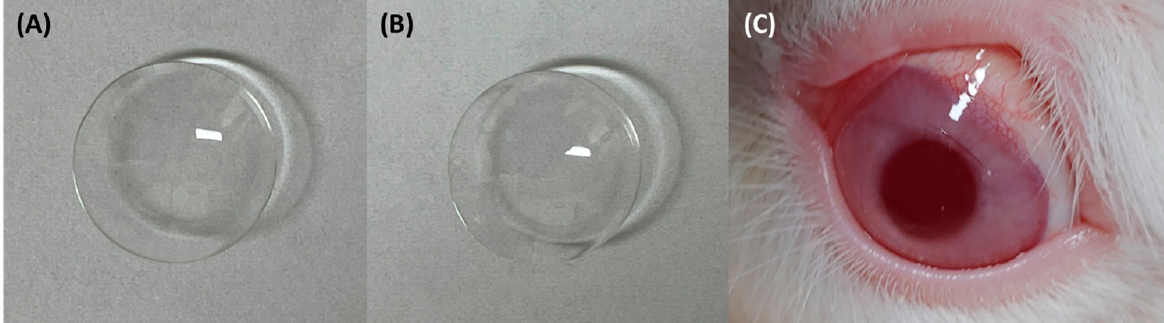
Figure 8. The picture of the naïve CL ( A ), CsA-CL ( B ), and CsA-CL-applied rabbit eye ( C ). CL: contact lens; CsA-CL: cyclosporine A-loading pH-responsive contact